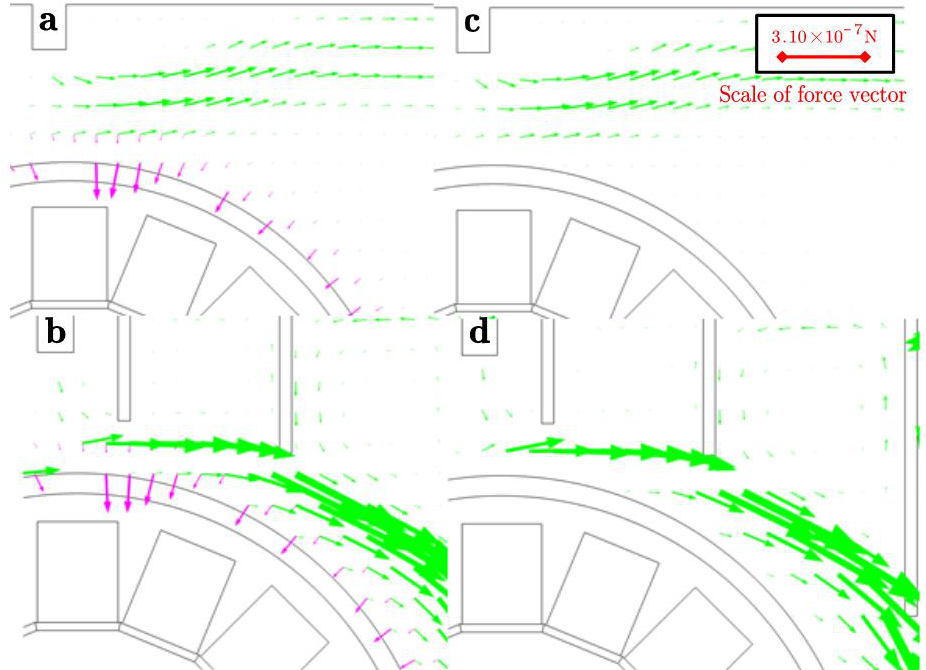
Figure 4. Force analysis of magnetite and quartz particles with a size of 23 μm ( airflow inlet velocity of drum surface = 1 m/s; rotating linear velocity of drum surface = 1 m/s). (Arrow: purple stands magnetic force, green for drag force and black for gravity (too small to show); original platform: ( a ) magnetite, ( c ) quartz; improved platform: ( b ) magnetite, ( d ) quartz).